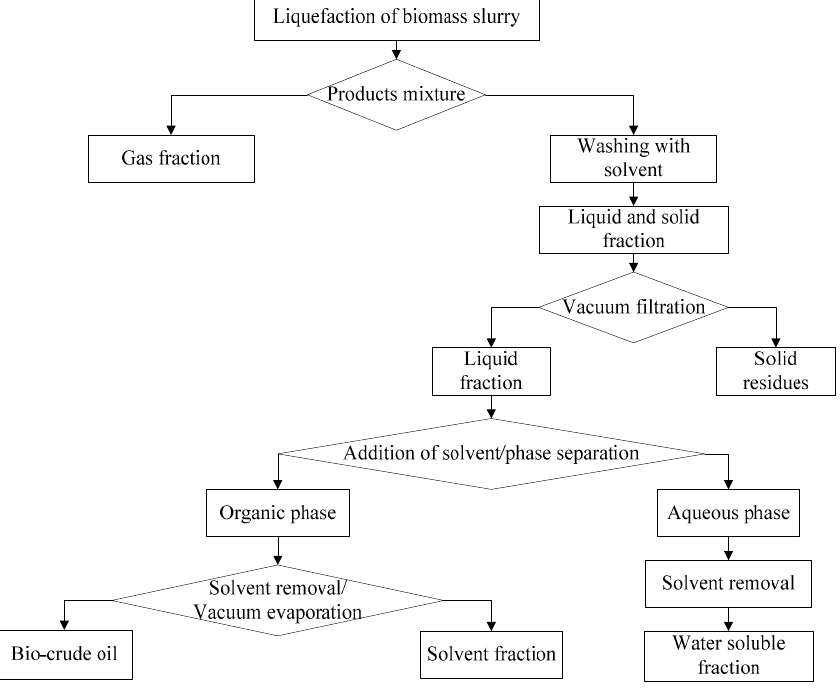
Figure 1. Hydrothermal liquefaction (HTL) product recovery workflow.